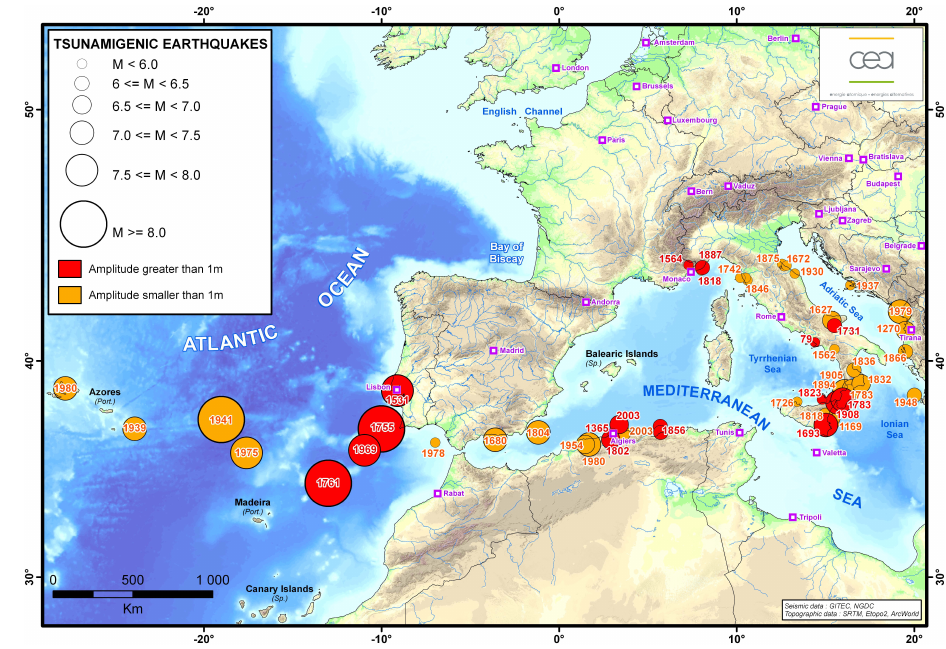
Fig. 1. Historical tsunamigenic seismicity in western Mediterranean and northeast